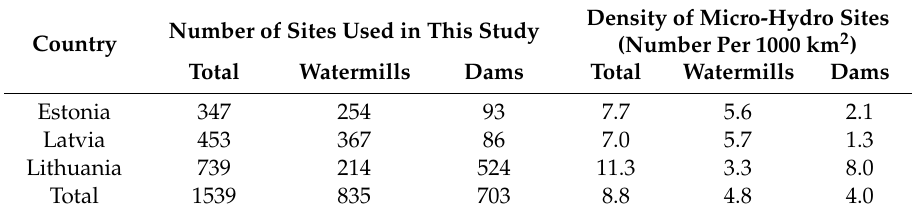
Table 4. Assessment of the historic and nonpowered dam site records in the Baltic States used in the study. Number of Sites Used in This Study Country